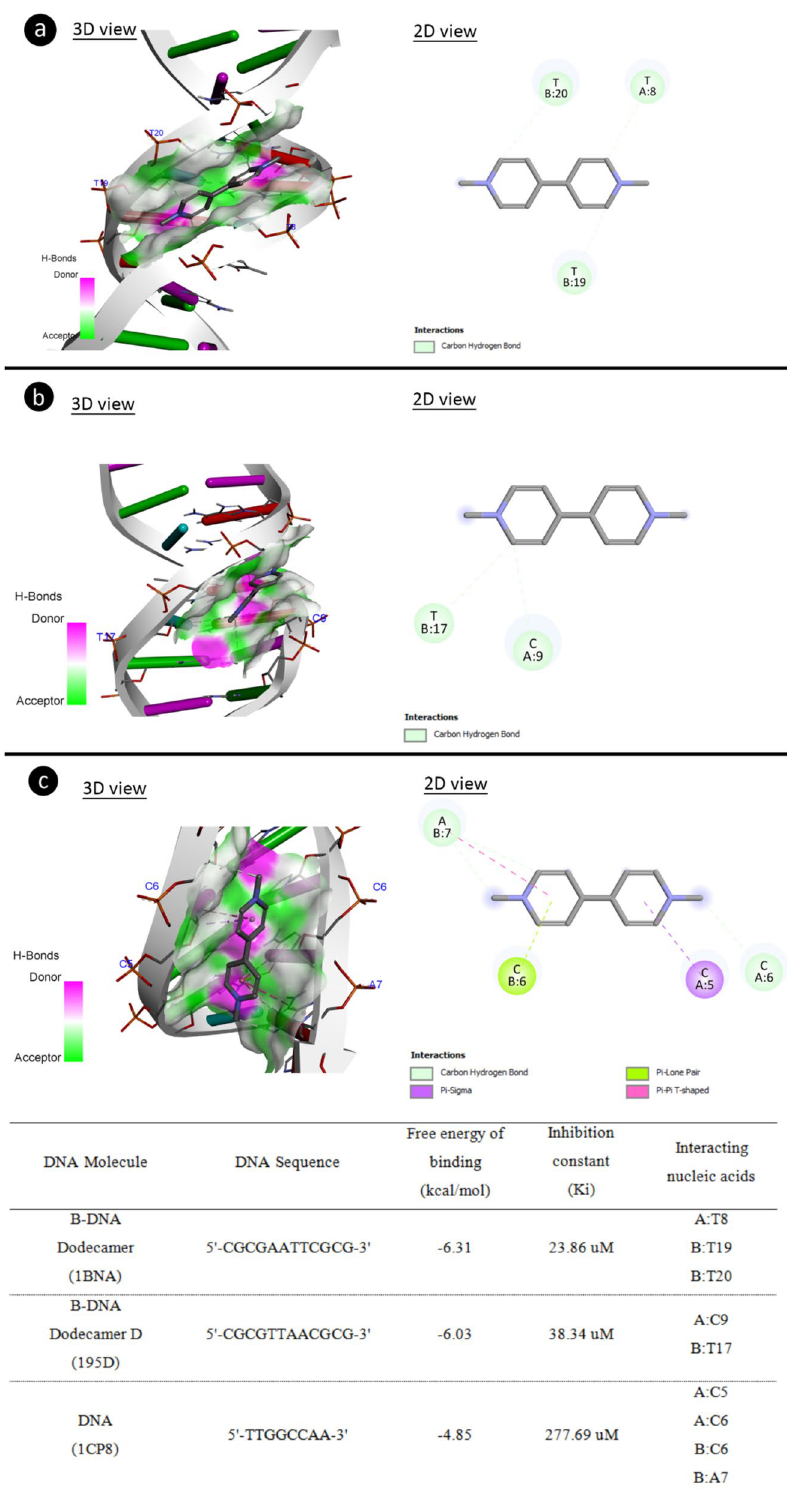
Figure 4. The structural interaction of Paraquat with DNA molecules. 1BNA ( a ), 195D ( b ), 1CP8 ( c